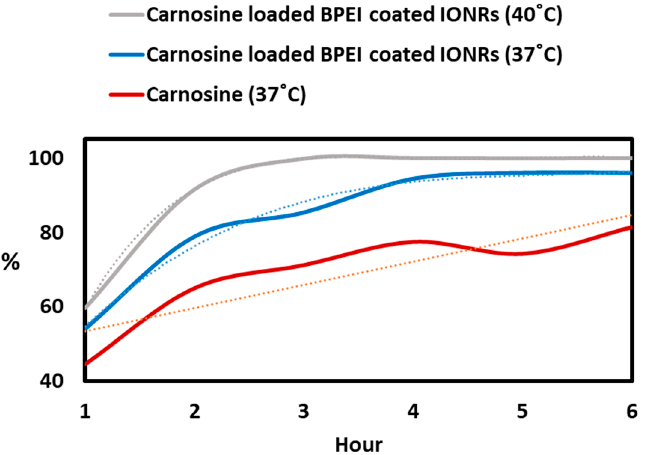
Figure 16. LC ‐ MS assay for the released carnosine from dialysis membranes containing free or loaded BPEI ‐ coated IONRs, under different conditions, at temperatures of 37 °C and 40 °C. The release of the embedded carnosine was enhanced exponentially in all conditions. Mild hyperthermia allowed the carnosine to be fully released between 3 and 5 h.